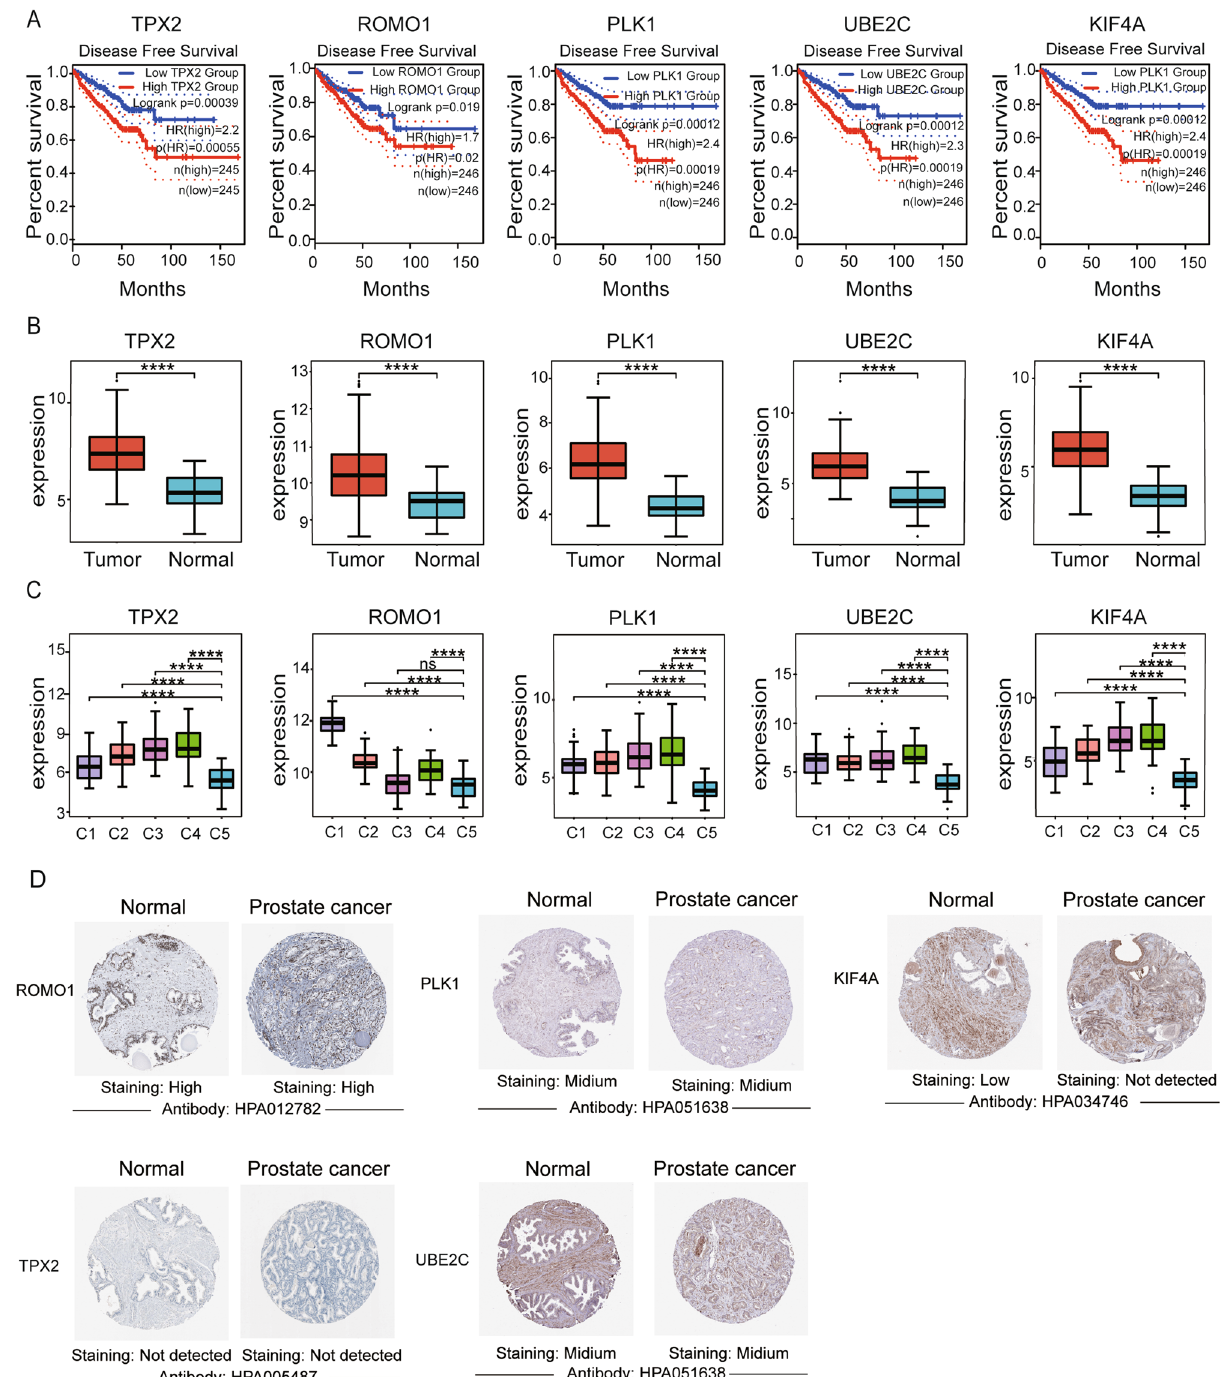
Figure 8. Performance of the five genes in different validation cohorts. ( A ). Prognostic value of mRNA expression of five key genes in PCa (GEPIA). PCa patients with high levels of key gene transcripts were significantly associated with short DFS. ( B , C ). Analysis of the expression levels of five key genes in PCa tissues and normal adjacent tissue based on the Wilcox.test method. ( C ). Analysis of the expression levels of five key genes in PCa para-cancer and four subtypes of cancer tissues based on the Wilcox.test method. The ****, ***, **, *, ns corresponding to 0, 0.001, 0.01, 0.05, 1. ( D ). Representational immunohistochemical images of ROMO1, PLK1, KIF4A, TPX2, and UBE2C in PCa and normal adjacent tissue from the HPA database. HPA, Human Protein